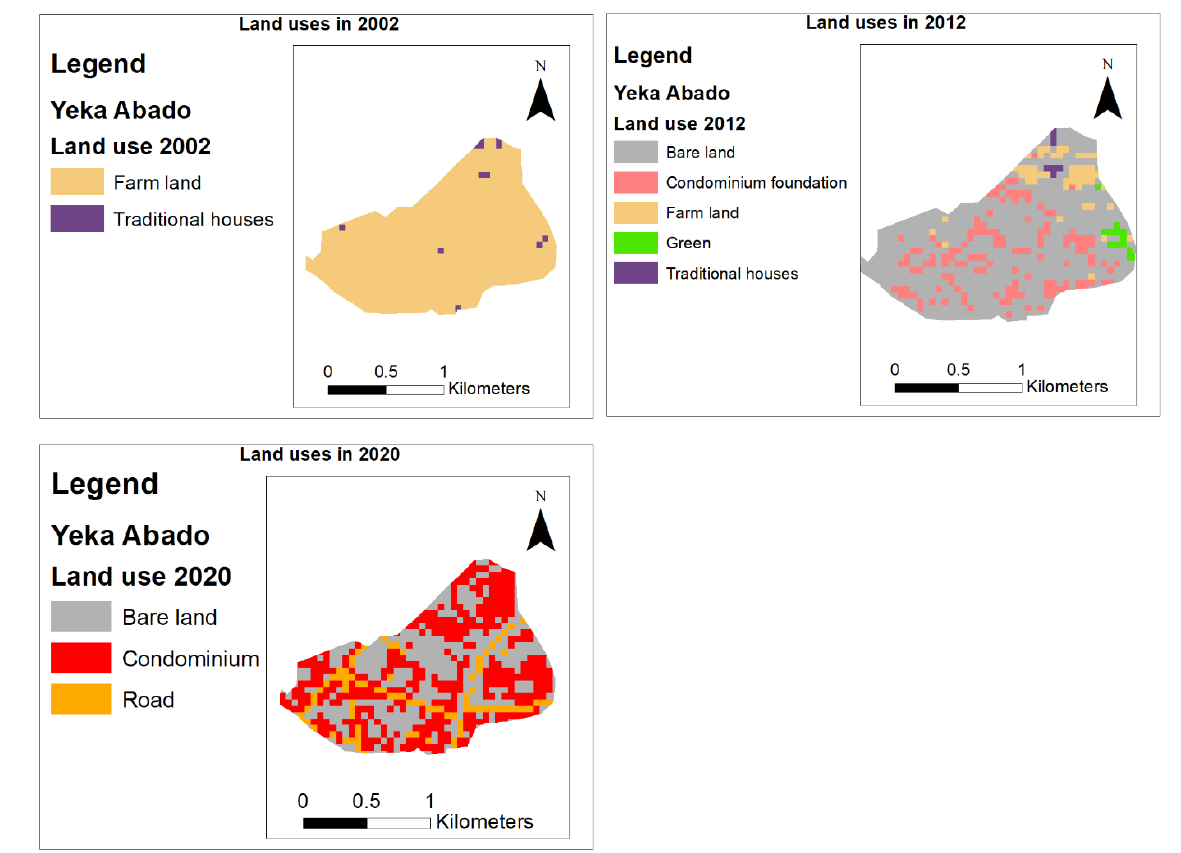
Figure 4. The land use composition for 2002, 2012, and 2020 at the urban fringes (Yeka Abado neighborhood).